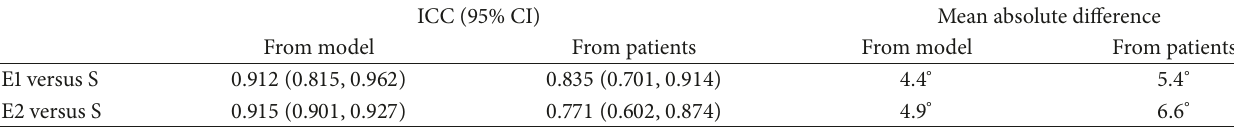
Table 3: Comparison between automatic and manual